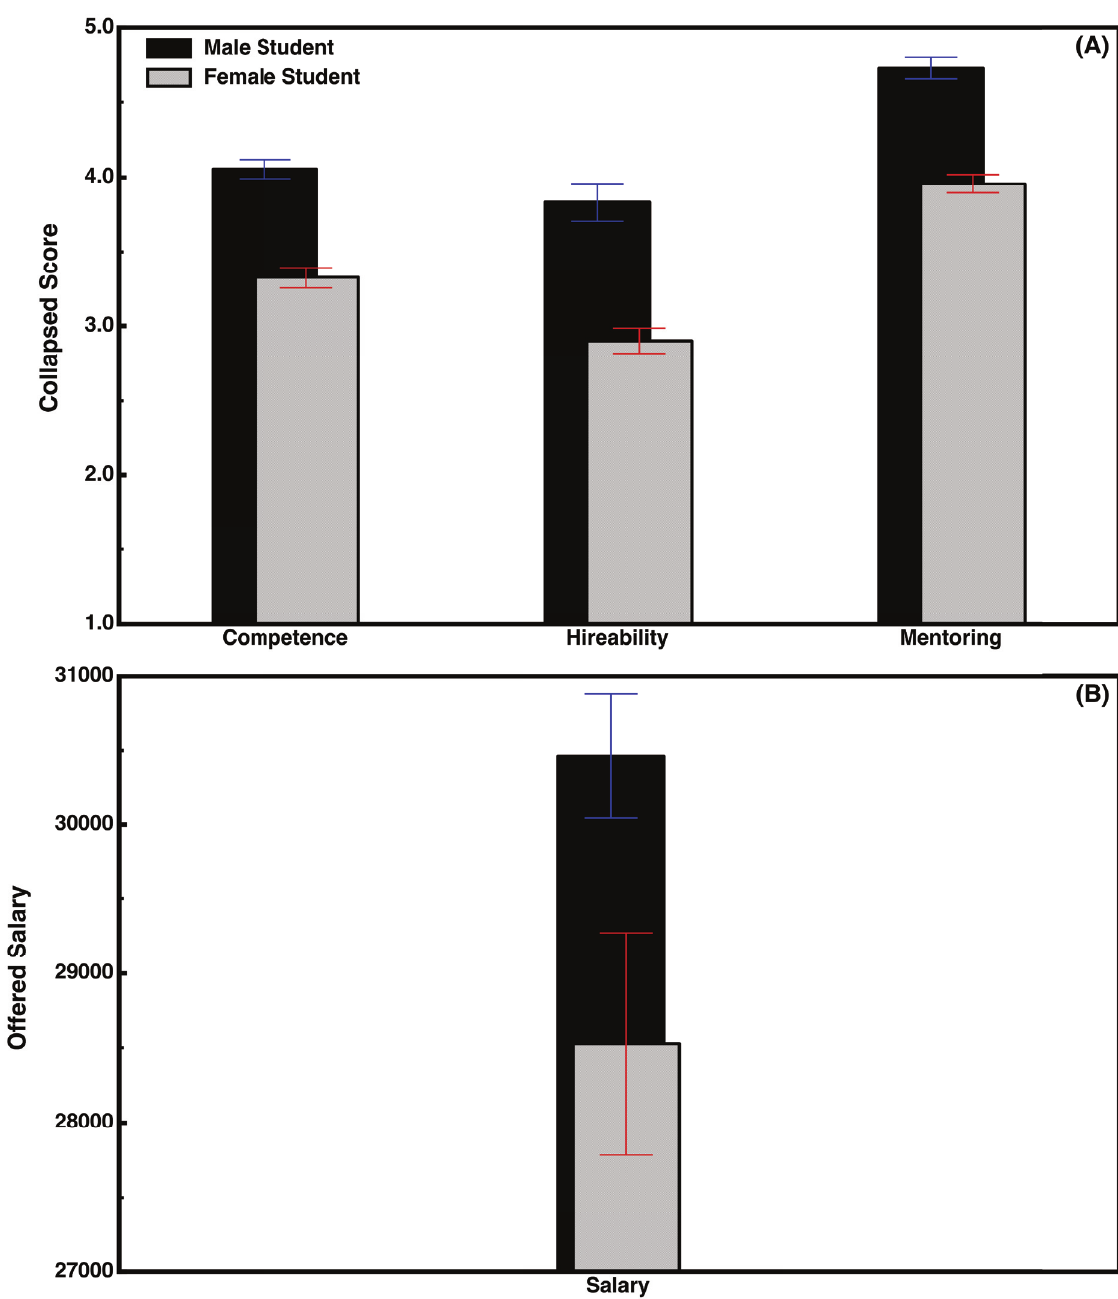
Figure 5. Collapsed results, independent of gender of evaluator, showing ( A ) competence, hirability and mentoring scores (assessed on a scale from 1 to 7), and ( B ) offered salaries, for male and female students. Based on data presented in ref. 41. Error bars represent standard deviation over the two genders. For methodological details and raw data, see ref.